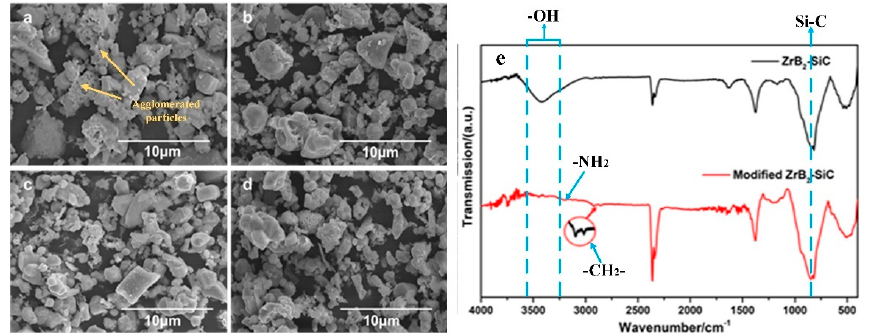
Figure 1. Micro-morphology and FTIR of surface-decorated ZrB 2 –SiC particles treated at different times: ( a ) Untreated, ( b ) 10 h, ( c ) 15 h, ( d ) 20 h, and ( e ) FTIR spectrum of the untreated ZrB 2 –SiC particles and the surface-decorated ZrB 2 –SiC particles with 20 h treatment.